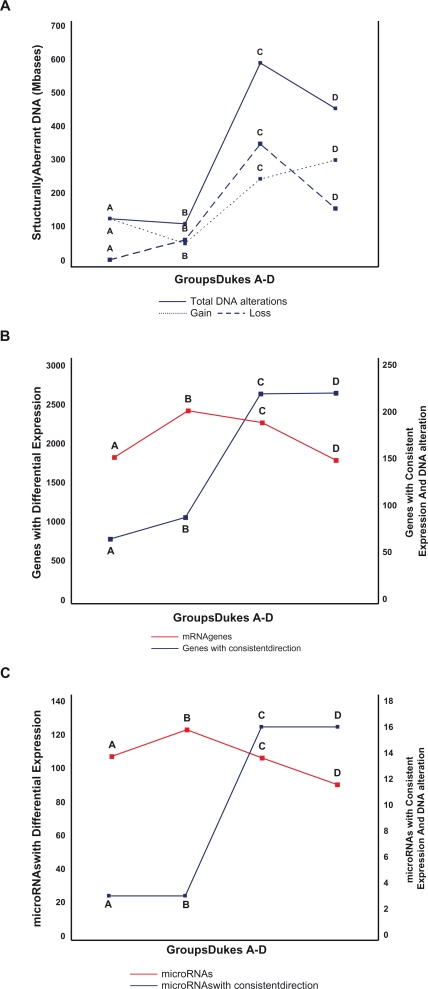
A) Distribution of aberrant DNA copy numbers across Dukes A, B, C and D tumors (solid line), DNA loss (dashed line) and gained (semidashed line). B) Distribution of significantly changed transcript expression across Dukes A-D tumors (red line) including significant interactions between DNA and RNA alterations (solid line). C) Distribution of significantly altered microRNAs across Dukes A–D tumors (red line) including significant interactions between DNA and microRNA alterations (solid line).